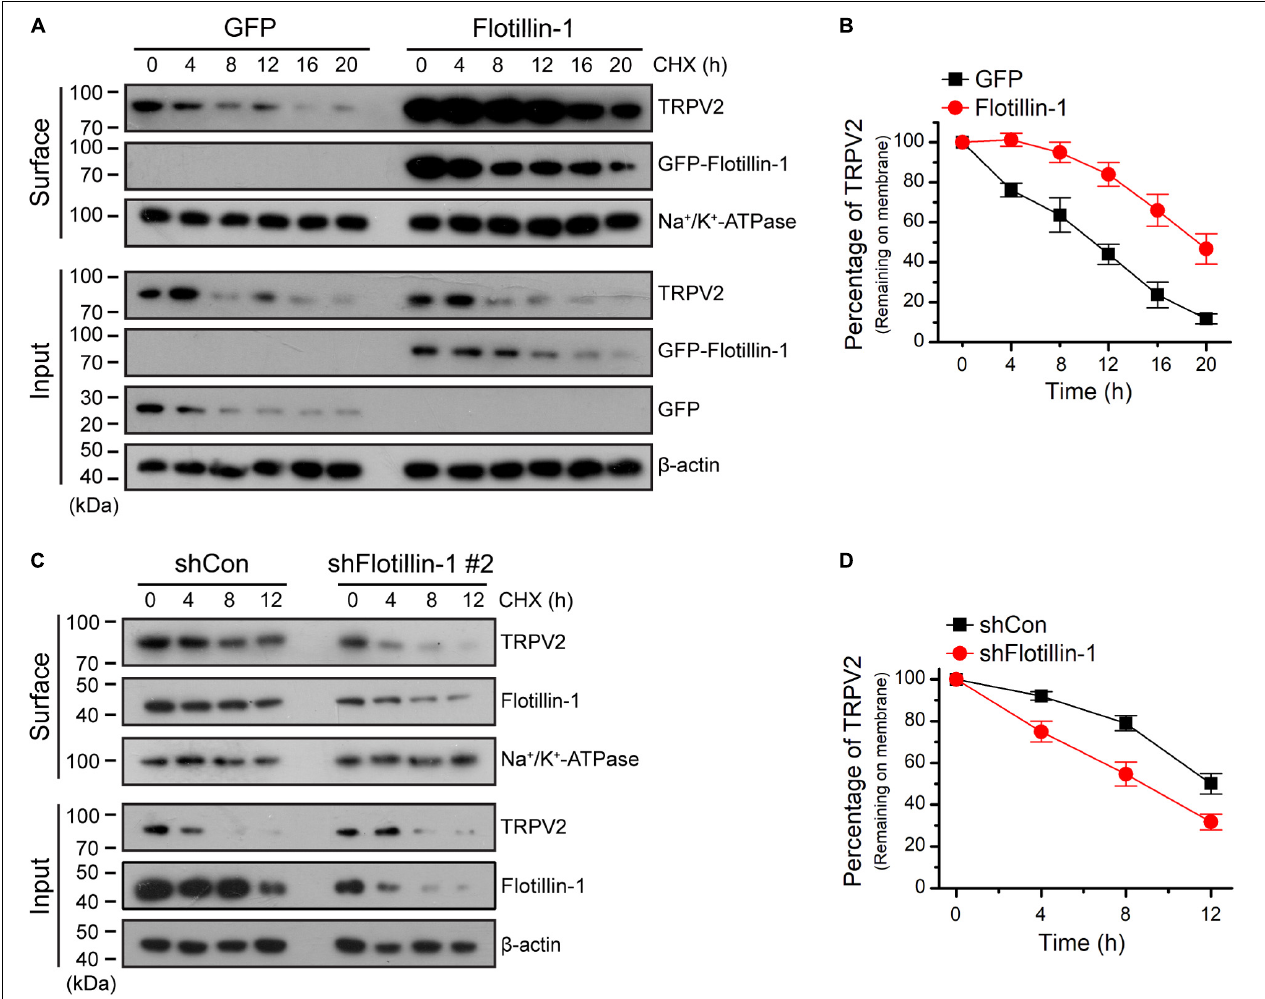
FIGURE 5 | Flotillin-1 sustains the surface stability of TRPV2. (A) Immunoblotting analysis of TRPV2 in ND7/23 cells time-dependently treated with the protein synthesis inhibitor cycloheximide (CHX, 100 µ g/ml) after being transiently transfected with GFP-tagged flotillin-1 or GFP. After plasma membrane proteins were biotinylated and purified with streptavidin-agarose, the surface levels of TRPV2 were analyzed by IB. (B) Quantitation of the surface levels of TRPV2 after treatment using CHX. Quantitation was performed by digitizing the immunoblots. (C) CHX-chase experiment assessing the surface stability of TRPV2 in ND7/23 cells that expressed shCon or shFlotillin-1 #2. Cells were treated with 100 µ g/ml of CHX for indicated times. (D) Quantification of the surface levels of TRPV2, showing a marked accelerate in endogenous TRPV2 degradation kinetics by knocking down flotillin-1 when compared to control cells. Data are representative of three independent